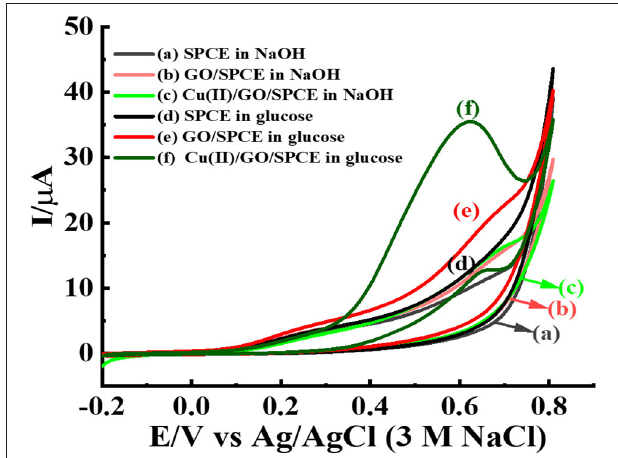
FIGURE 8 | CVs of different modified electrodes; bare SPCE, and GO- and GO/Cu(II)-modified SPCEs in 0.10M NaOH solution with the absence and presence of 5.0mM glucose at a scan rate of 50mV s − 1 .